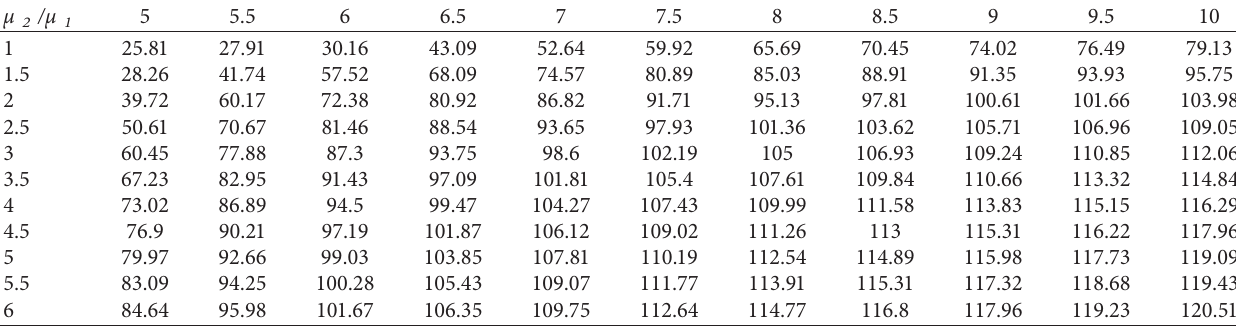
Table 1: The optimal revenue of service provider versus μ